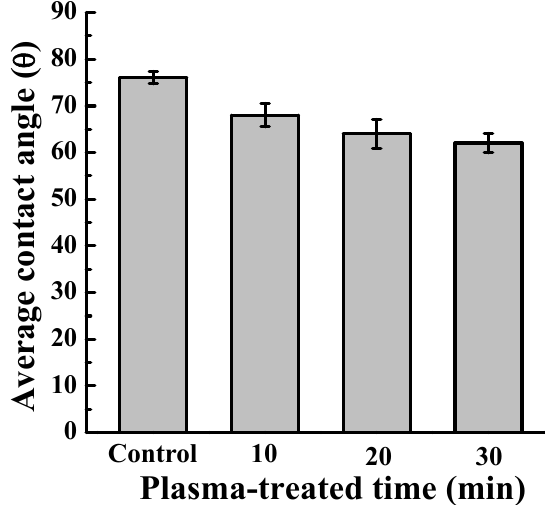
Figure 5. Wettability of the plasma ‐ oxidized sample at 280 W for various treatment durations.